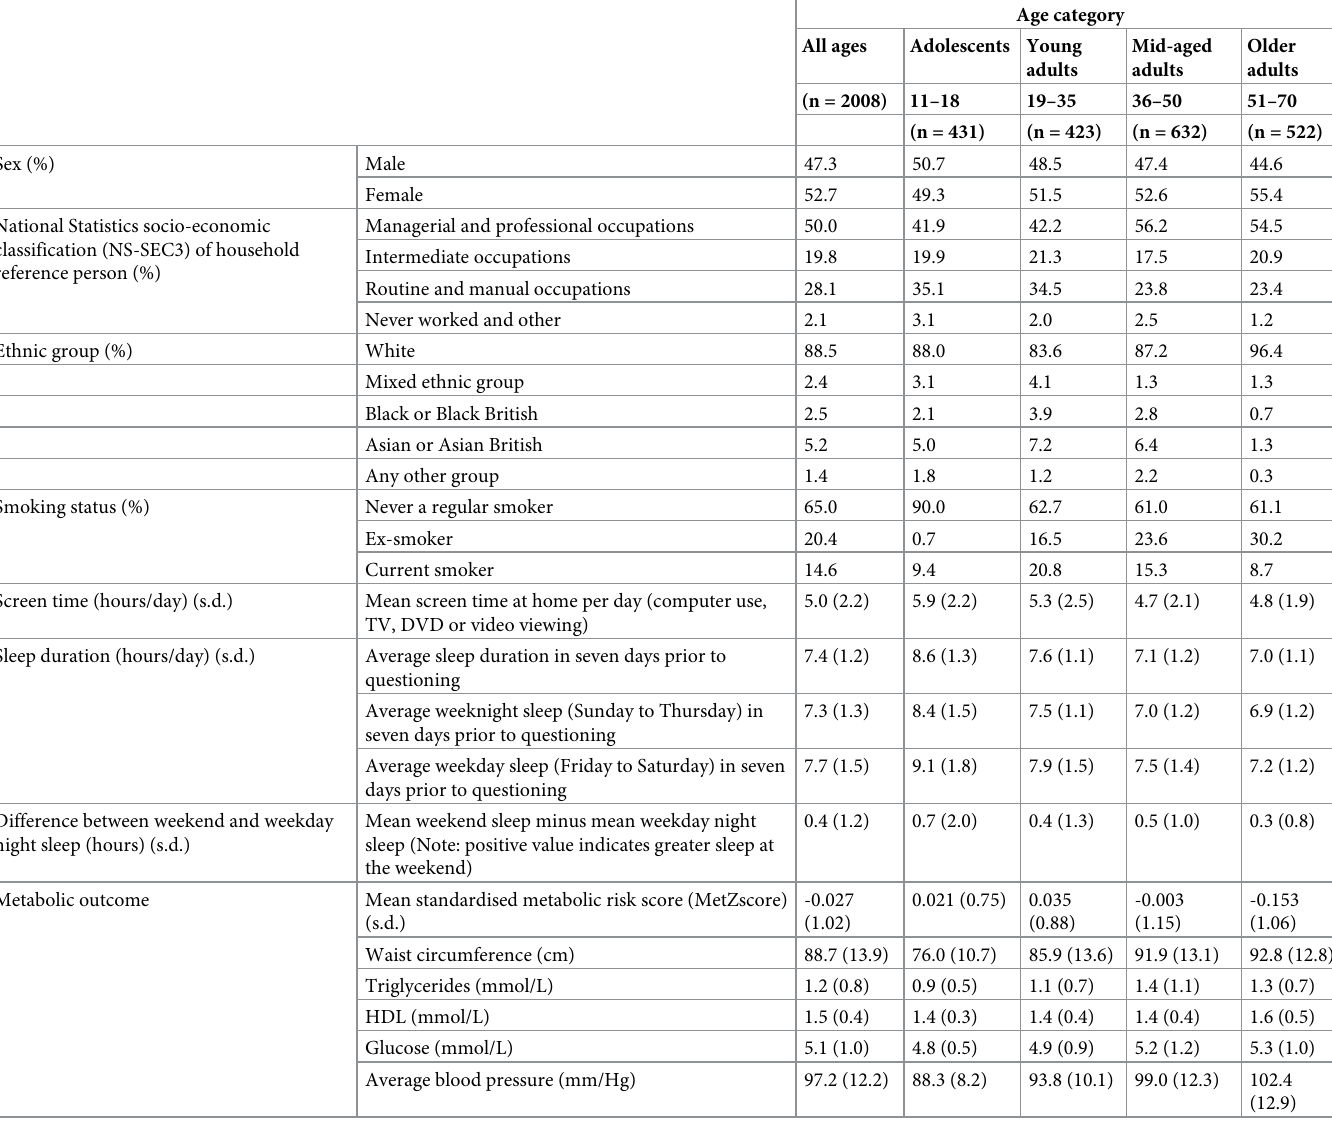
Table 1. Descriptive statistics of the weighted sample, grouped by age category, from the NDNS Years